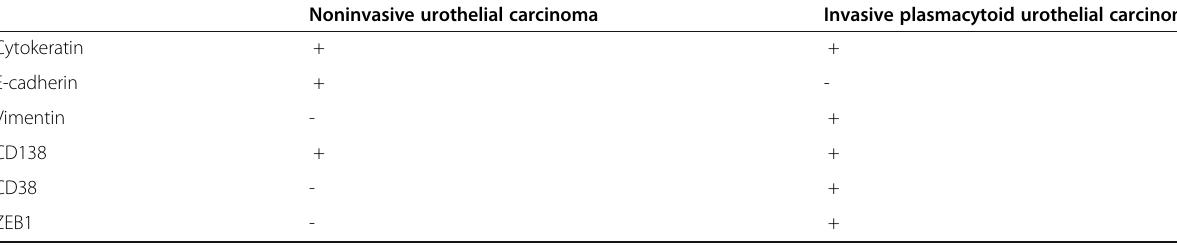
Table 2 Immunoreactivities for two distinct morphological